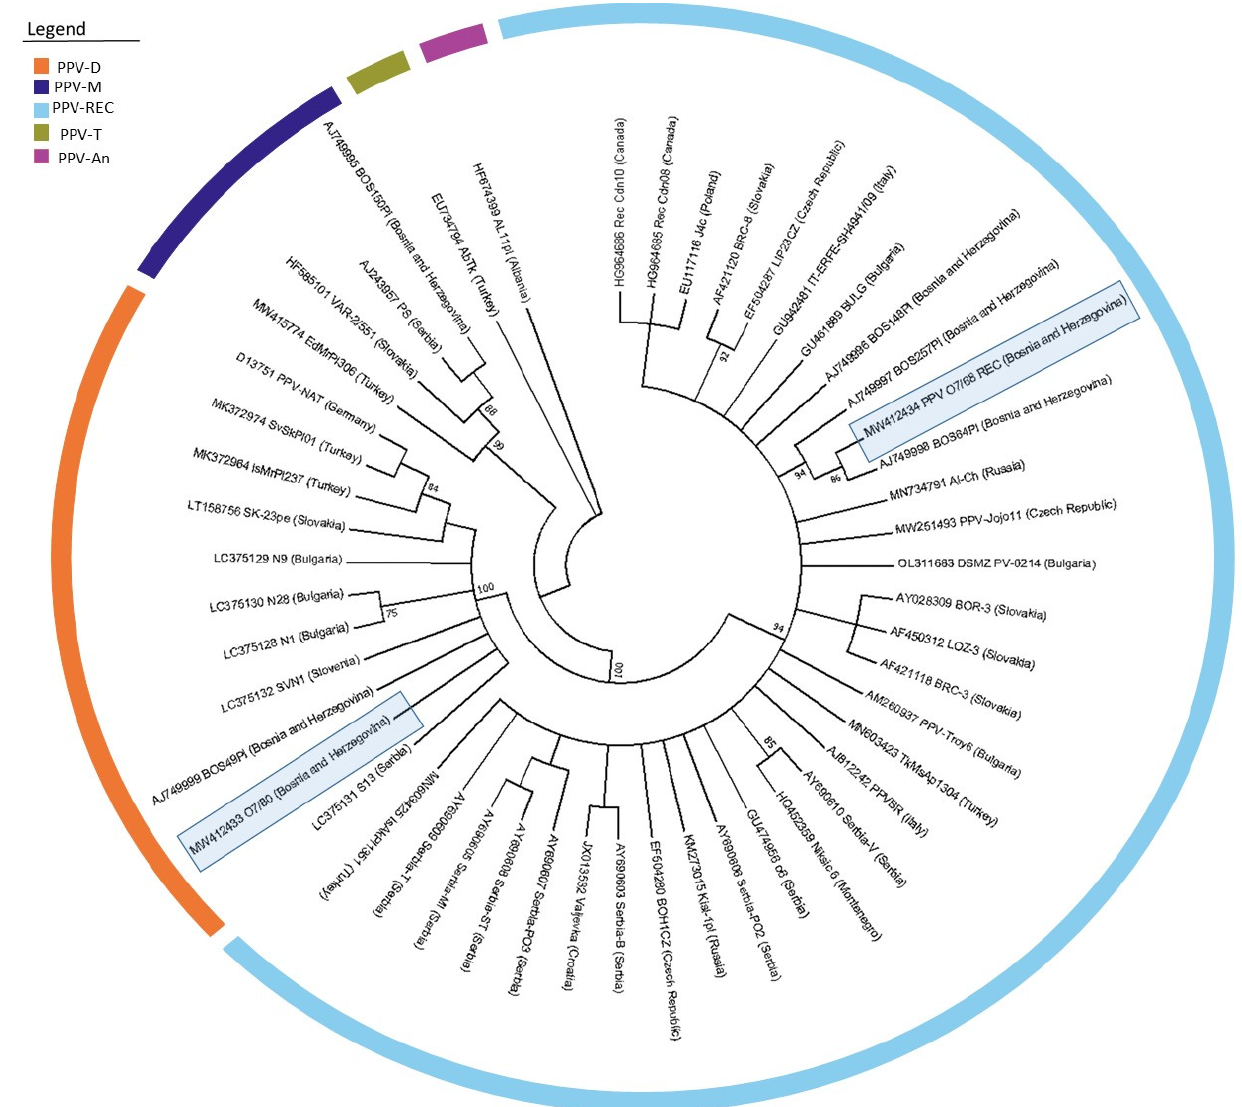
Figure 3. Maximum likelihood phylogenetic tree constructed from the analyzed (Cter)NIb/(Nter)CP region. Isolates obtained in this study (PPV_O7/80; MW412433 and PPV_O7/68, MW412434) are labeled in a blue box. The tree was constructed using the GTR+G+I model with 1000 bootstrap replications and rooted on the ancestor isolate (HF674399). Bootstrap values of 75% or more (out of 1000 replications) are indicated on the branches. Strains are color coded as shown in the legend.